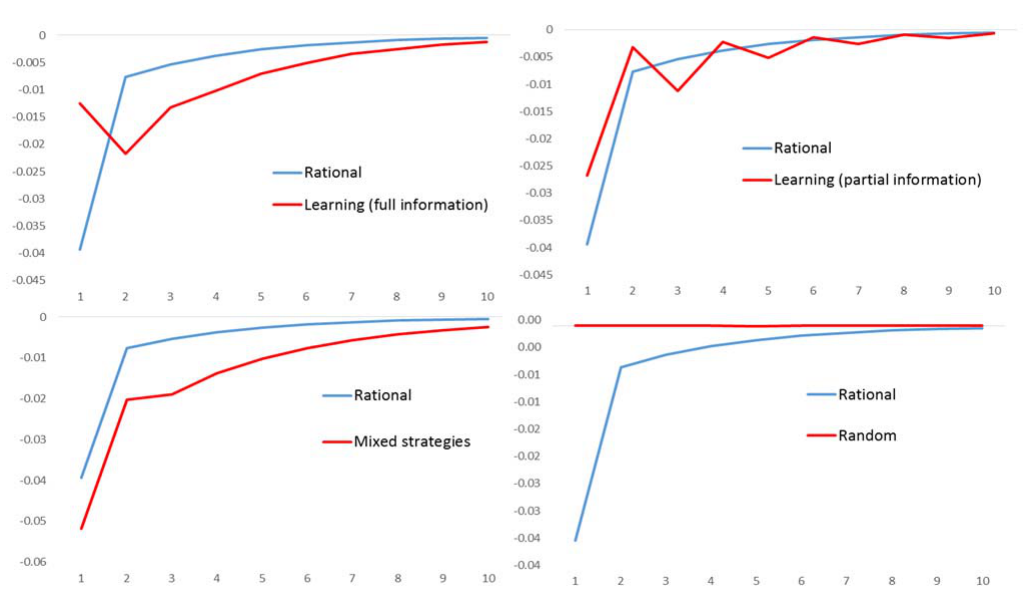
Figure 2. Responses of output to innovation in